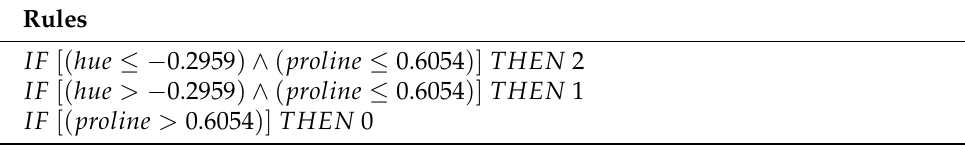
Table A20. Final rule set for the wine quality dataset generated by